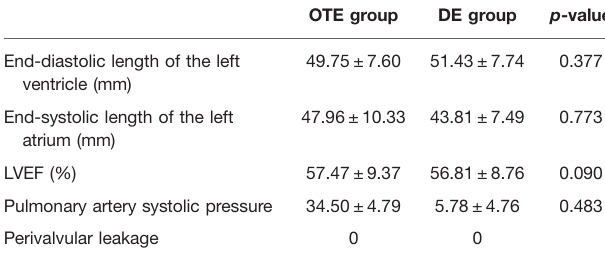
TABLE 3 | 3 months follow-up data comparison between two groups.